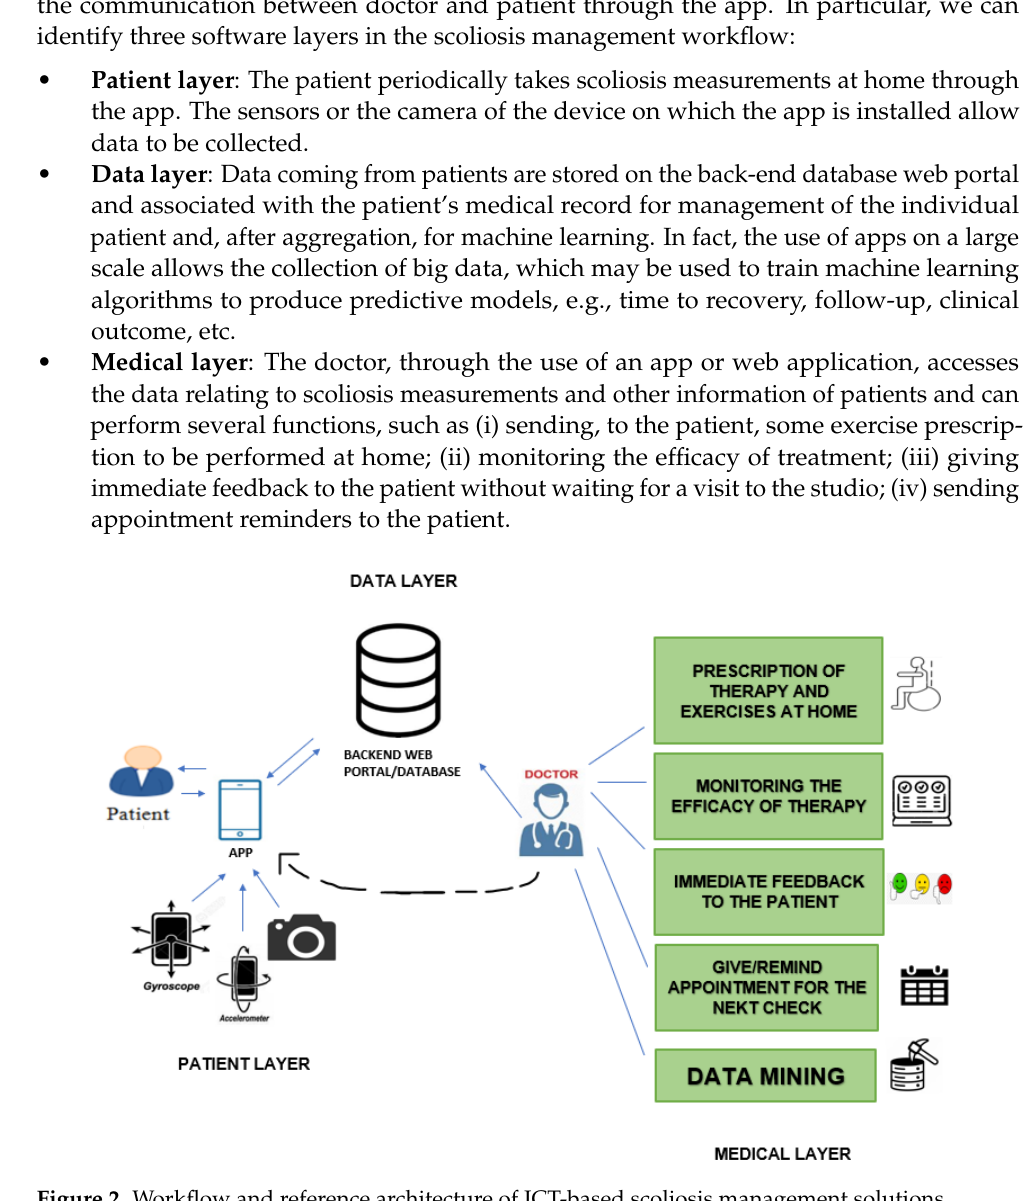
Figure 2. Workflow and reference architecture of ICT-based scoliosis management